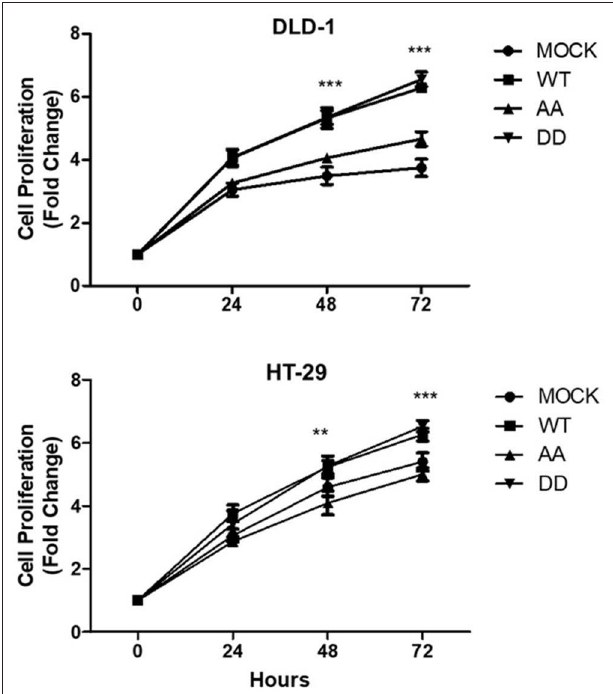
FIGURE 2 | Biphospho-mimetic ECE1c DD increases proliferation of CRC cells. DLD-1 (upper) and HT-29 (lower) CRC cells overexpressing Flag-tagged ECE1c WT , ECE1c AA , or ECE1c DD were grown for 24, 48, and 72h under normal conditions and proliferation was evaluated by CFSE assay and flow cytometry. Graphs represent mean ± SEM; ** p < 0.01; *** p <